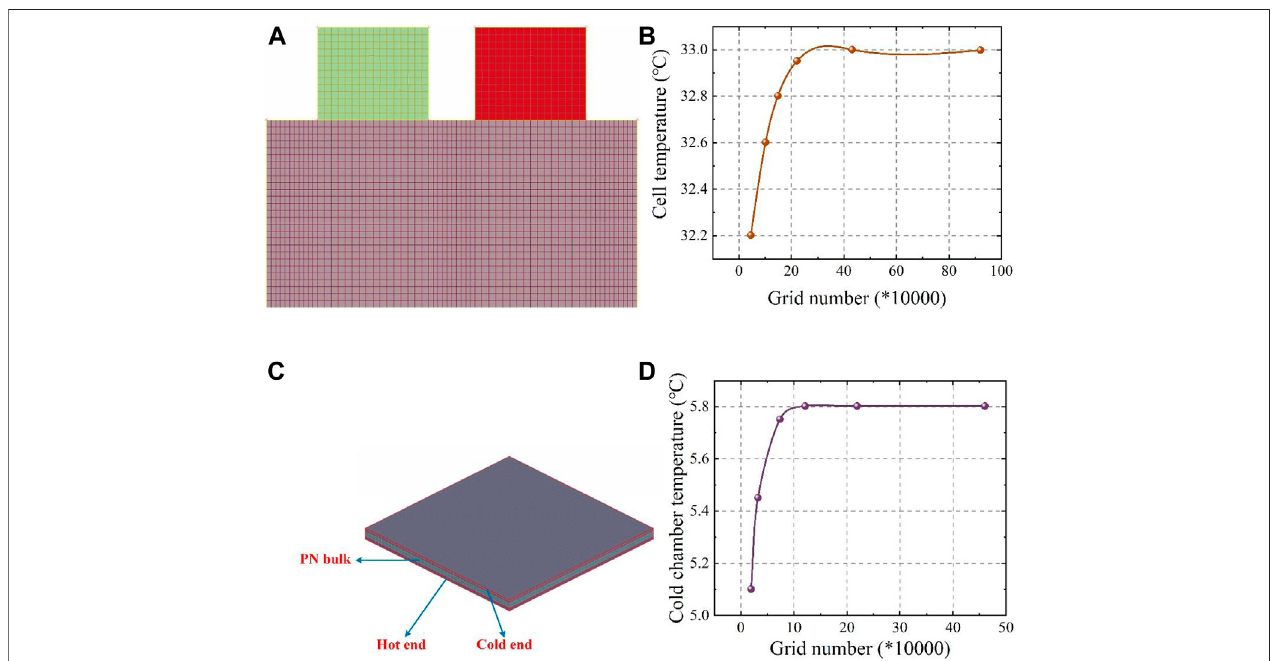
FIGURE 3 | (A) Computational grid of cell; (B) The grid independence veri fi cation of cell; (C) Computational grid of Semiconductor; (D) The grid independence veri fi cation of semiconductor.